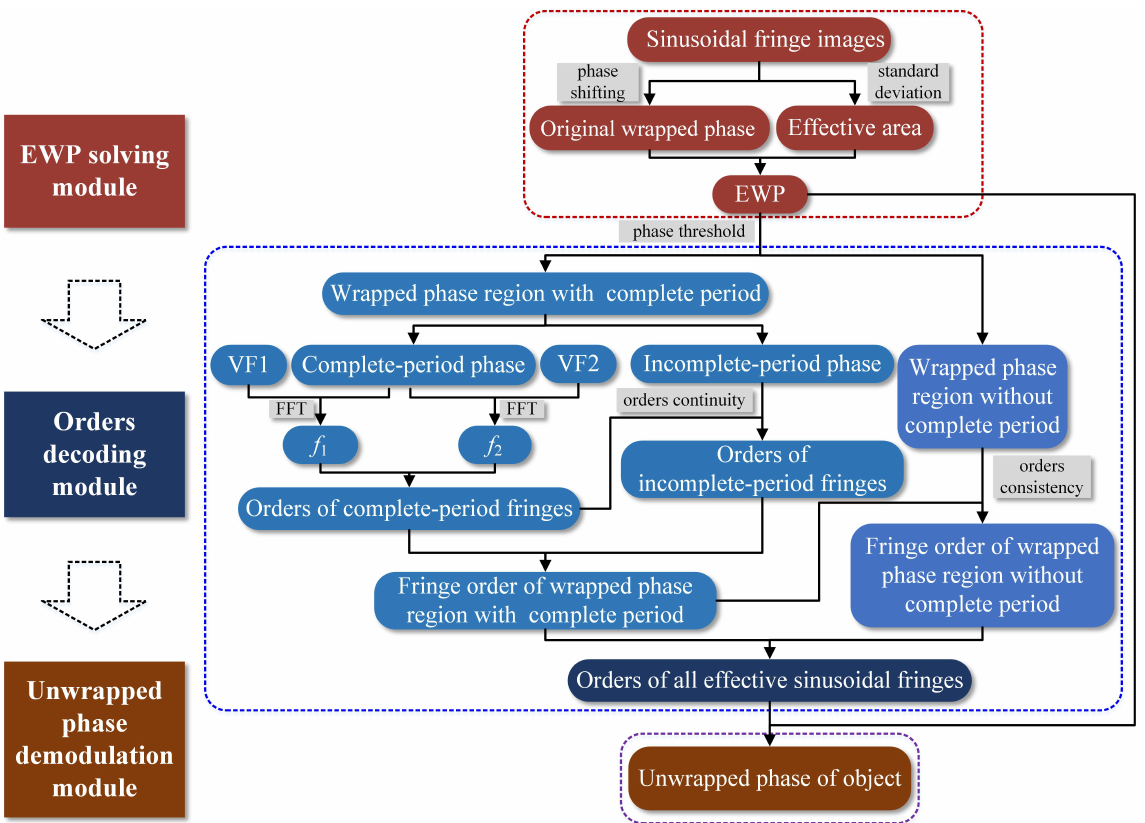
Figure 3. Flow chart of the effective phase